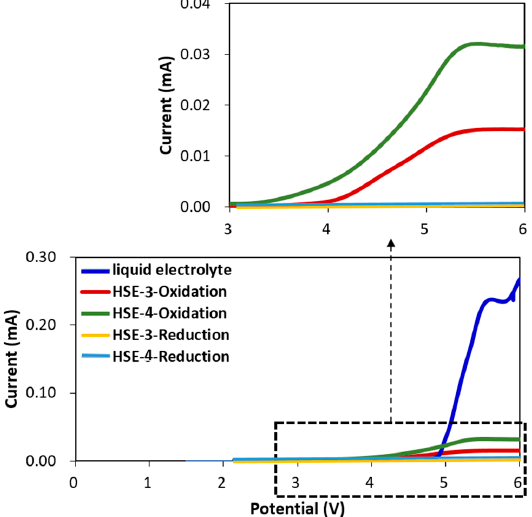
Figure 4. Linear sweep voltammetry (LSV) scans of HSE-3 and HSE-4. Pt is employed as a working electrode and Li metal is employed as reference electrodes. Scan rate is at the 1